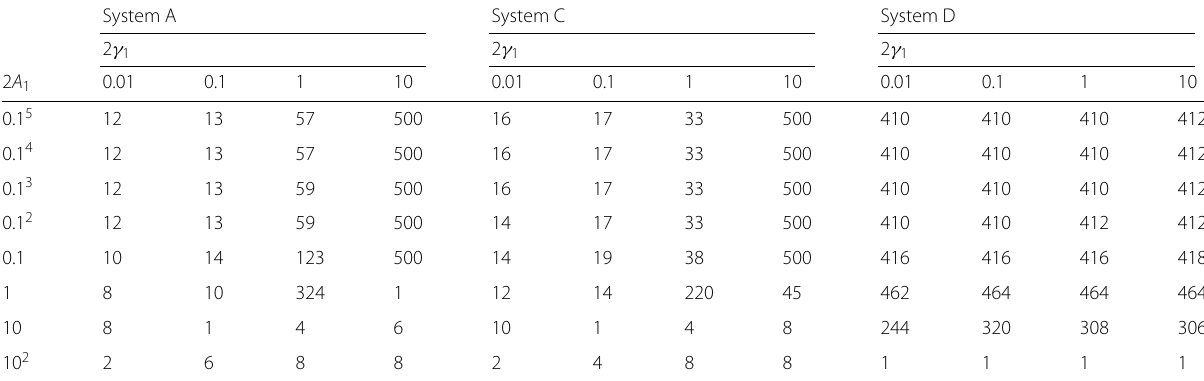
Table 4 Number of consecutive iterations yielding realistic behavior ( N R ) for Systems A, C and D, and a set of values for the parameter pair ( A 1 , γ 1